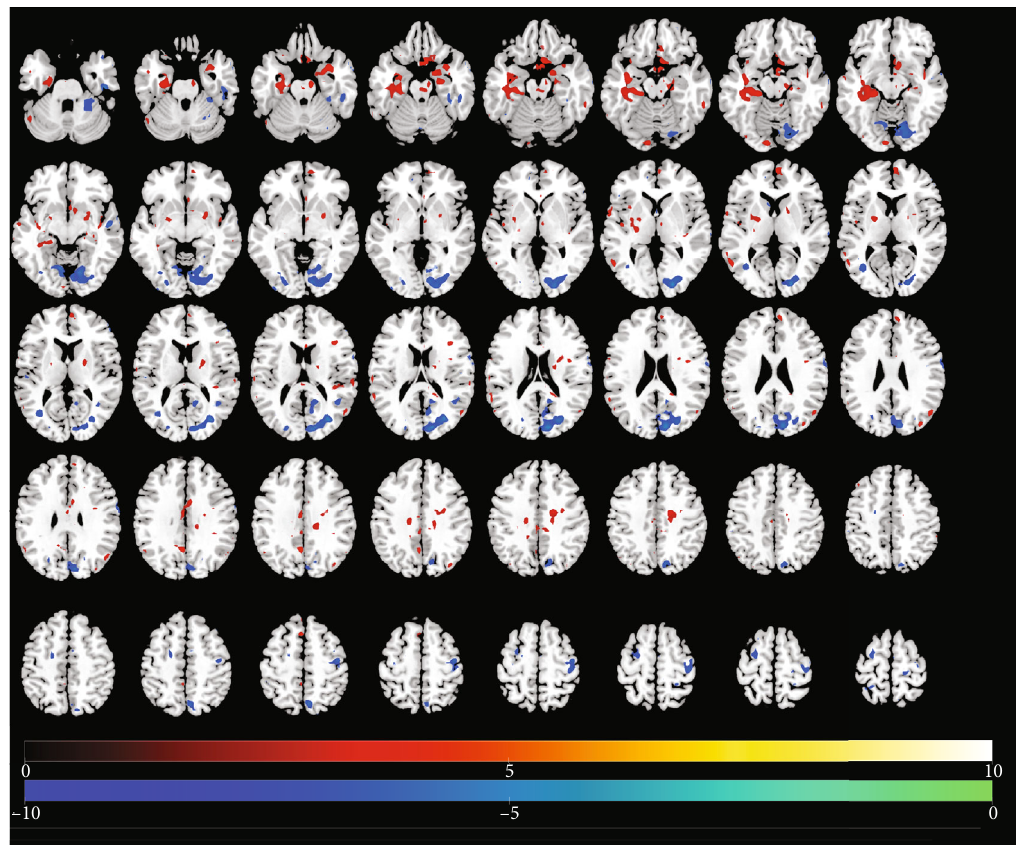
Figure 1: Identi fi cation of changed regional brain activity 2 months after traumatic amputation by using rs-fMRI. Relative magnitude of ALFF between upper-limb amputee patients ( n = 16 ) and normal control subjects ( n = 8 ) is plotted in axial images (top to bottom, inferior to superior). Colors toward red indicate increases in ALFF (signi fi cant t -values), and colors toward blue indicate signi fi cant decreases in ALFF relative to controls (cf. Table